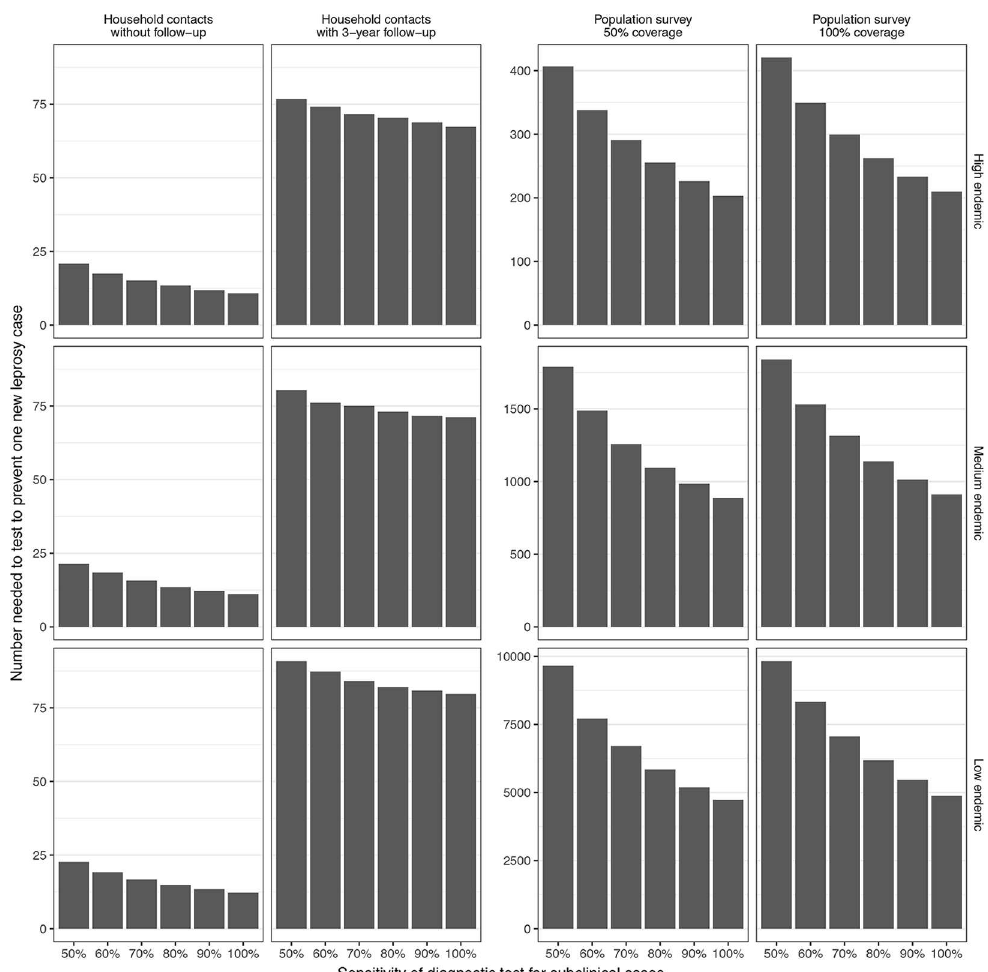
Fig 2. Number needed to test to prevent one new leprosy case. Results present the efficiency of a diagnostic test in household contacts and a population survey under various assumptions of sensitivity in a high, medium and low endemic setting. High endemic is defined as 25 per 100,000 population, medium as 5 per 100,000, and low as 1 per 100,000.